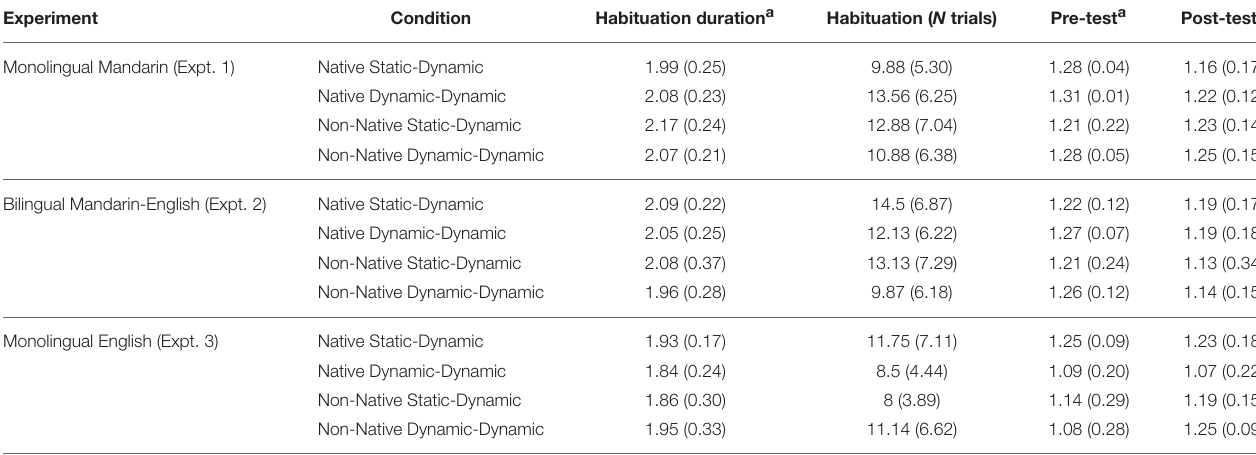
TABLE 2 | Mean ( SD ) habituation duration, number of habituation trials, pre- and post-test fixations in the four conditions of Experiments 1, 2, and 3. Experiment Condition Monolingual Mandarin (Expt.